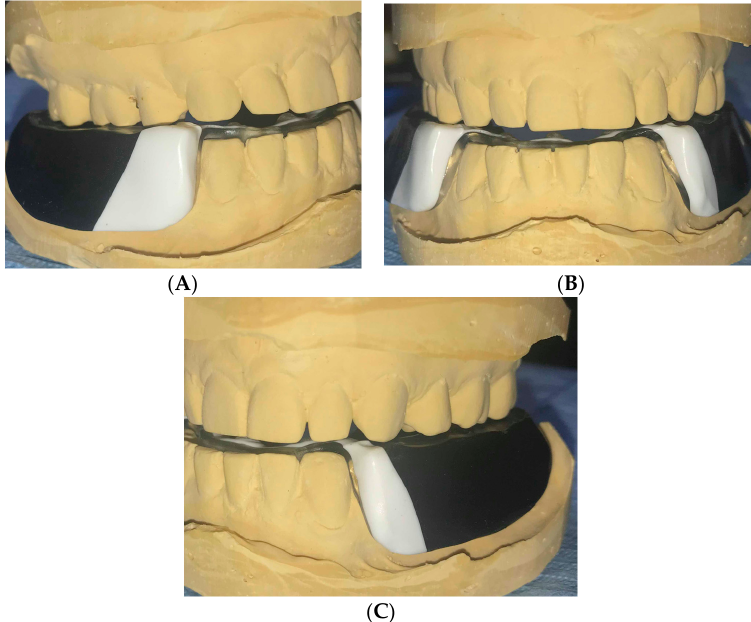
Figure 5. Dental casts and the OSSPD. ( A ) Right side view; ( B ) Frontal view; ( C ) Left side view.